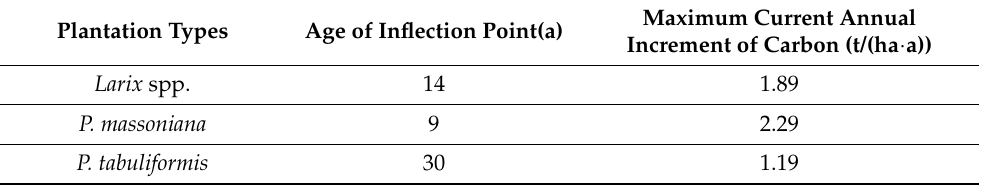
Table 6. Comparison of average increment of carbon storage on different ages among the three